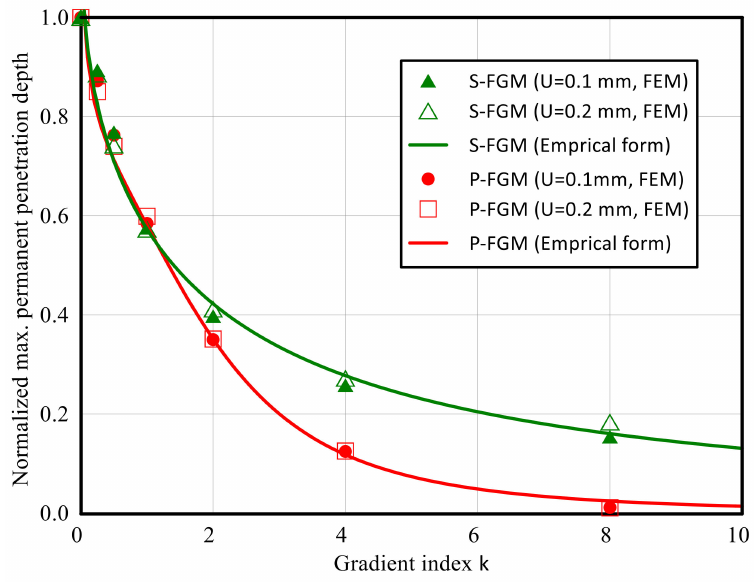
Figure 16. Prediction of the permanent indentation depth as a function of the gradient index for both S-FGM and P-FGM functions of elastoplastic Ti/TiB specimen, accounting for the gradation in all material properties.